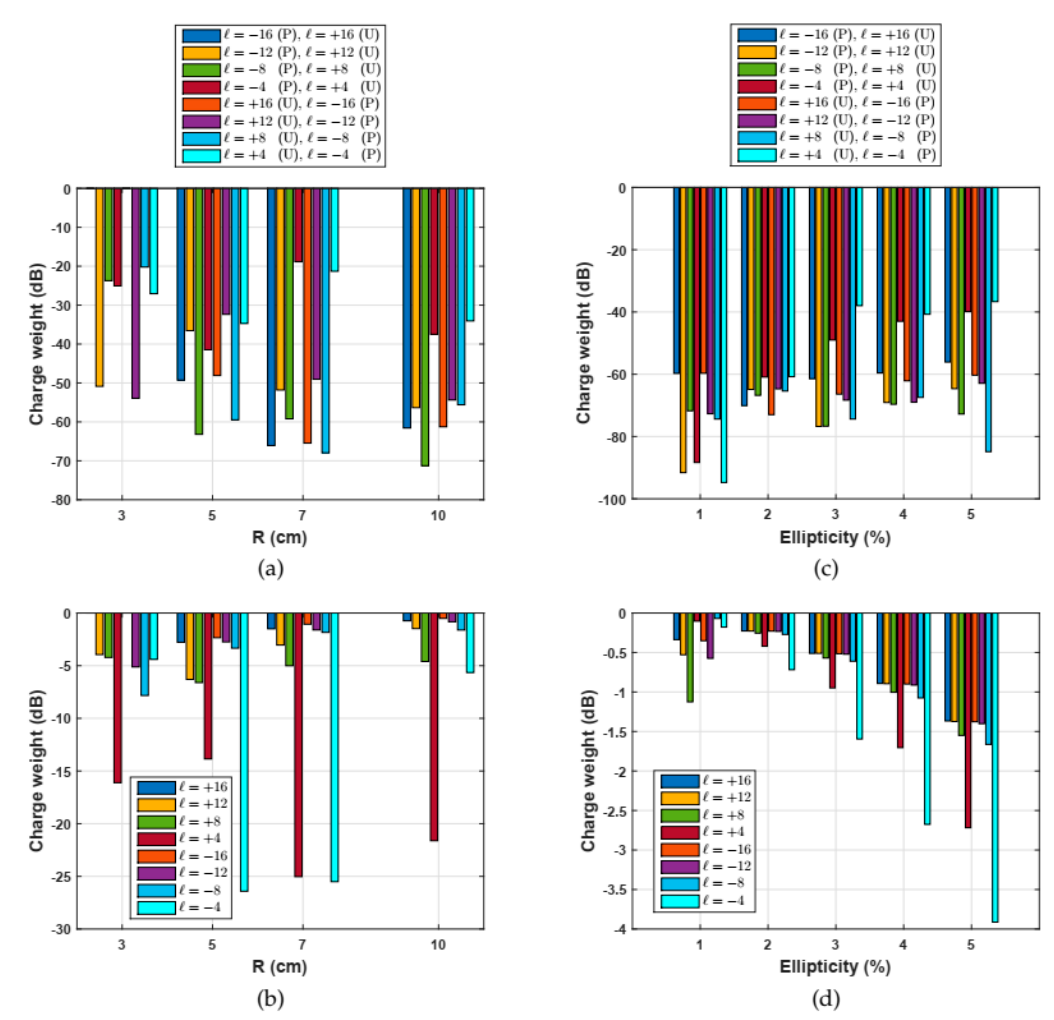
Figure 10. ( Right ) OAM Spectra in dB units between some perturbed (P) and unperturbed (U) modes, and considering bending of 3, 5, 7, and 10 cm. ( a ) OAM modes with opposite orbital charges, + l and − l , of the same value. ( b ) OAM modes with the same orbital charge + l or − l of the same value. ( Left ) OAM Spectra in dB units between some perturbed (P) and unperturbed (U) modes and considering ellipticity from 1 up to 5%. ( c ) OAM modes with opposite orbital charge +4 and − 4 of the same value. ( d ) OAM modes with the same orbital charge + l or − l of the same value.